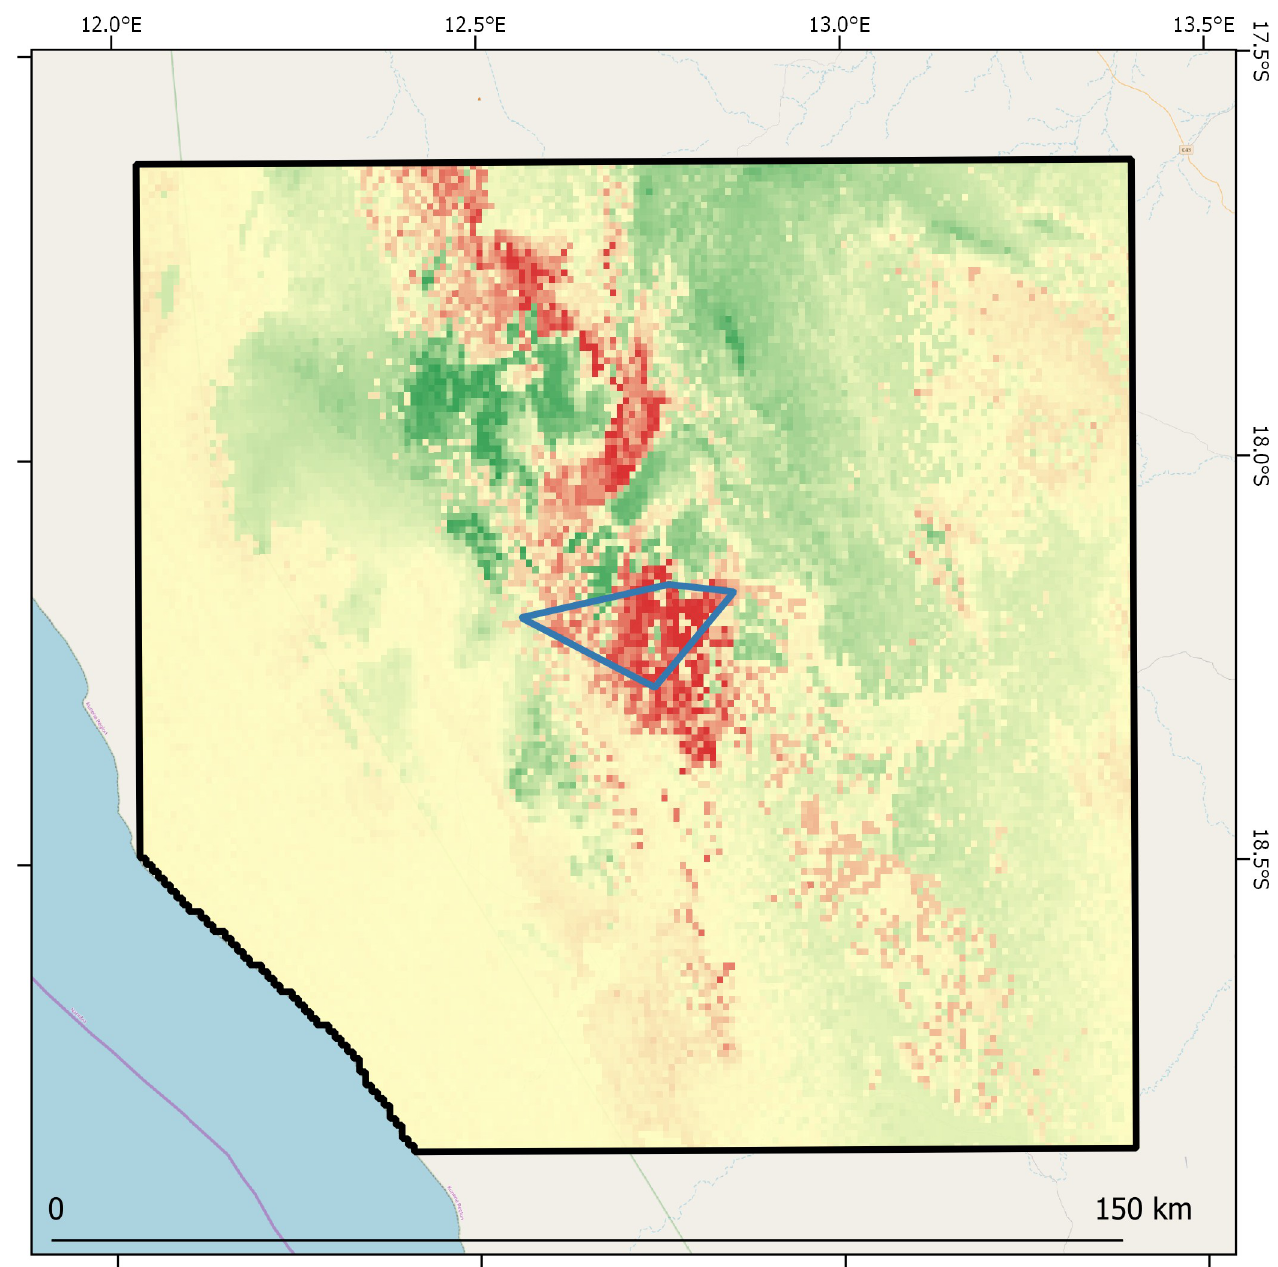
Fig 4. Variation of climatic suitability for W . mirabilis in the study area. Expected suitability variation from climate change (red and green shades indicate negative and positive variations respectively) calculated as the difference between future and historical suitability. Black polygon indicates the study area, and the blue polygon represents the boundaries of the observed extent of occurrence in Northern